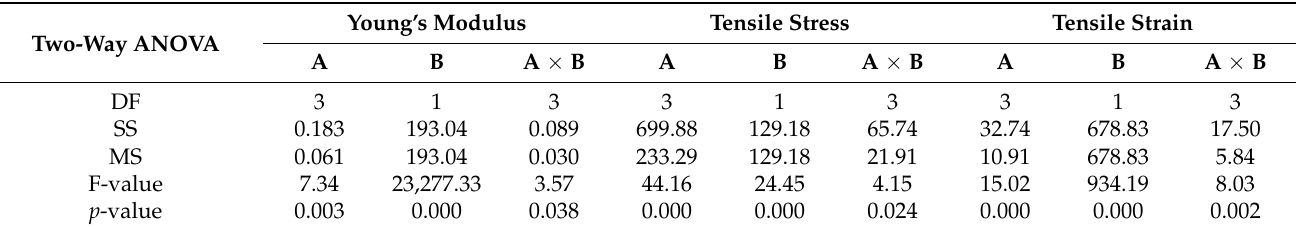
Table 2. Two-way ANOVA results of varied 3D printed PHB/UDMA towards tensile properties.